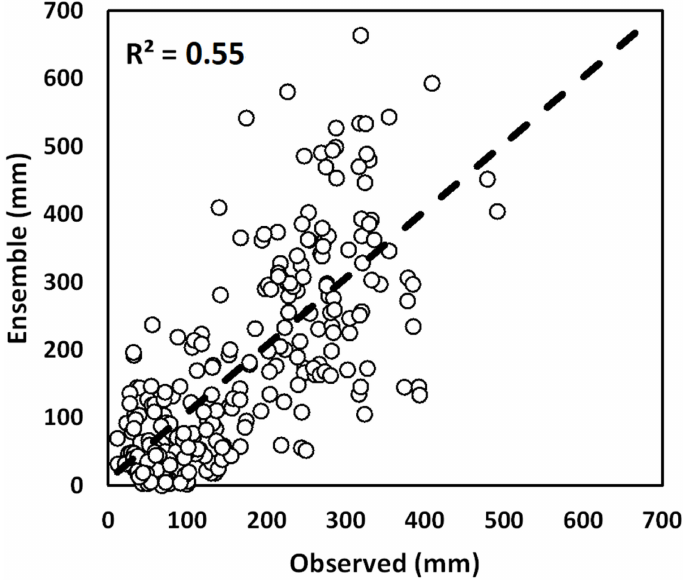
Figure 4. Scatter plot for the simulated (ensemble) and observed monthly precipitation in Altamira for the 1979–2010